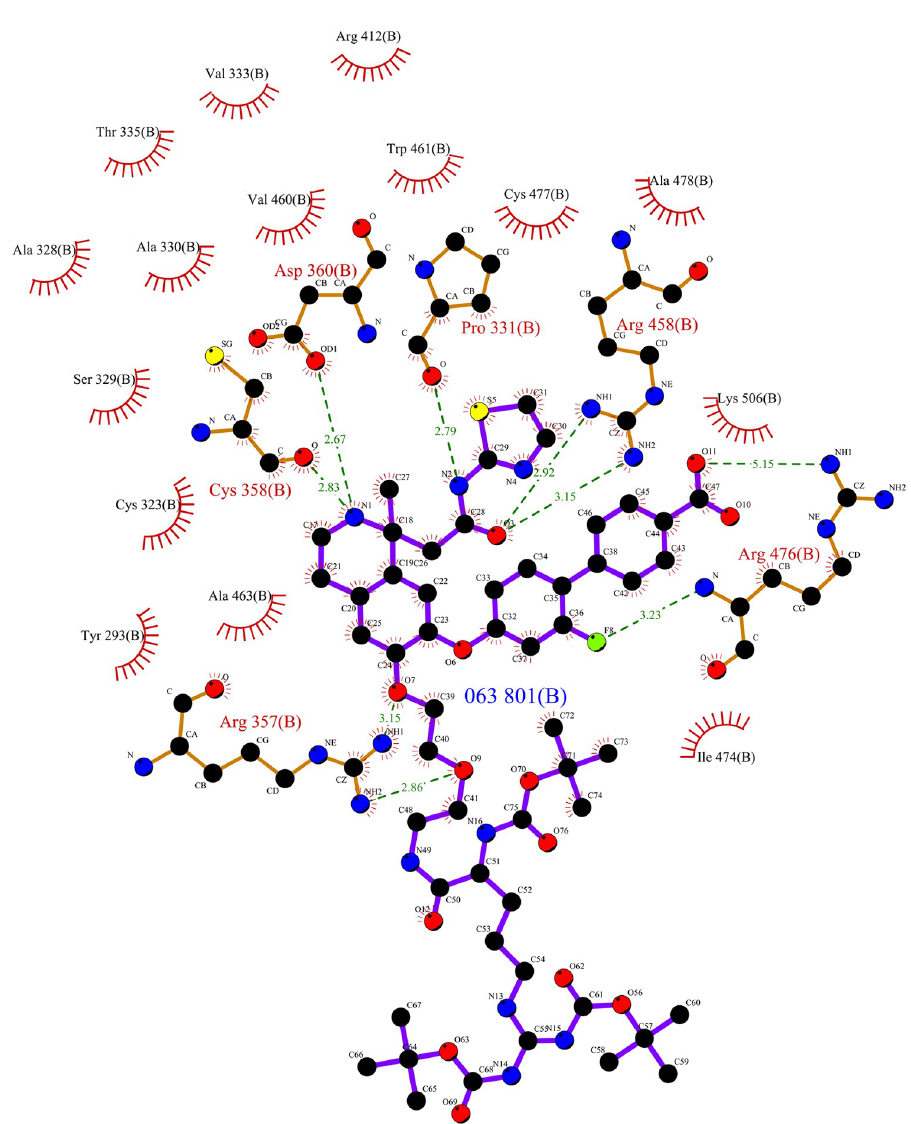
Fig 1. LIGPLOT for 6U26 showing the active site pocket from PDBsum [71].